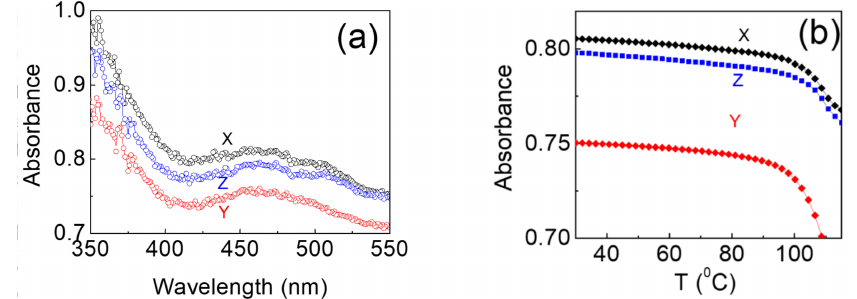
Figure 4. ( a ) Spectra of A X , A Y and A Z , the absorbances for the three directions, X, Y and Z. To be noted is that the di ff erence is substantial between A X and A Y , and less so between A X and A Z . ( b ) Temperature dependence of A X , A Y and A Z at 404 nm . Interestingly in the vicinity of the N-I transition, A Y shows a much larger variation than the other two